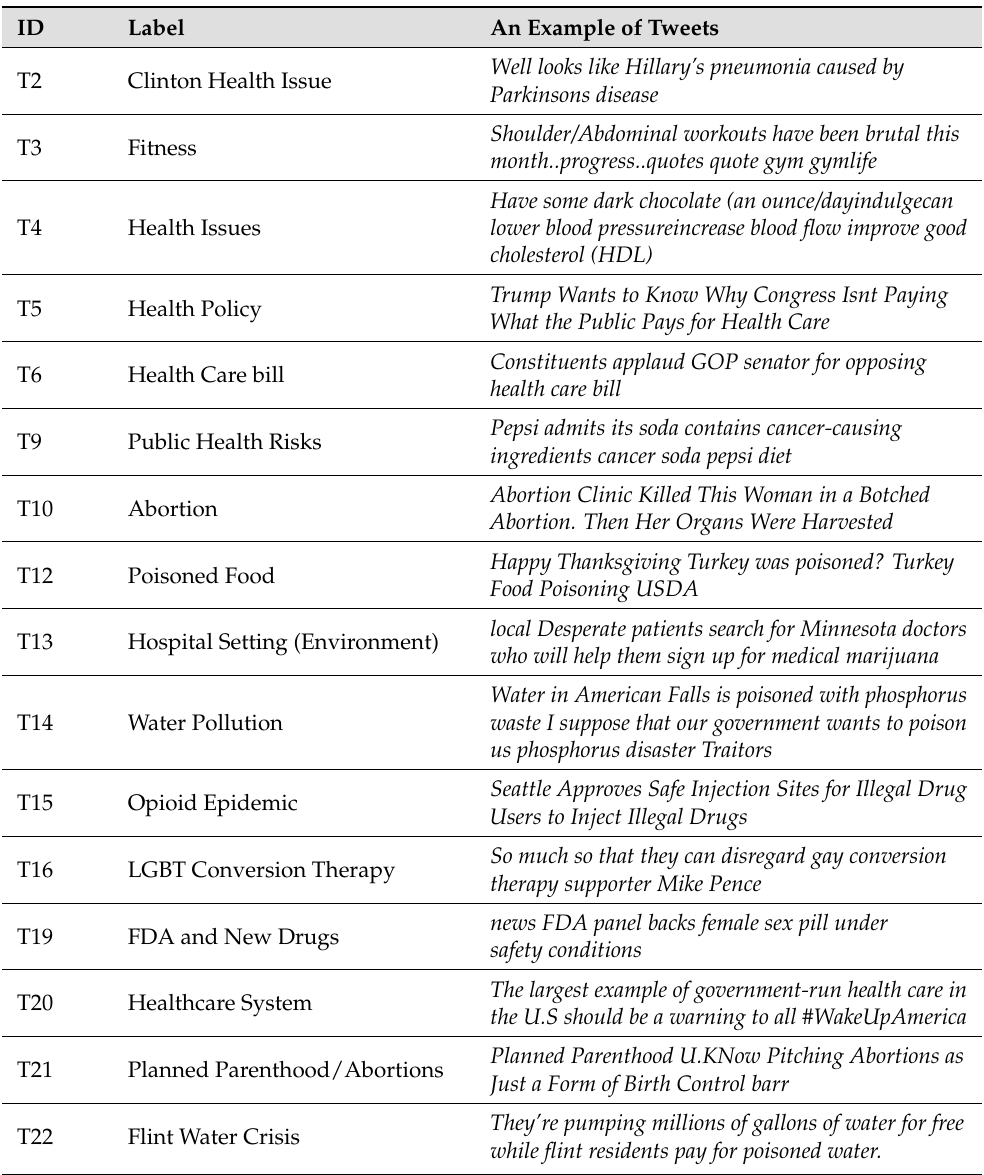
Table A1. An example of tweets for each